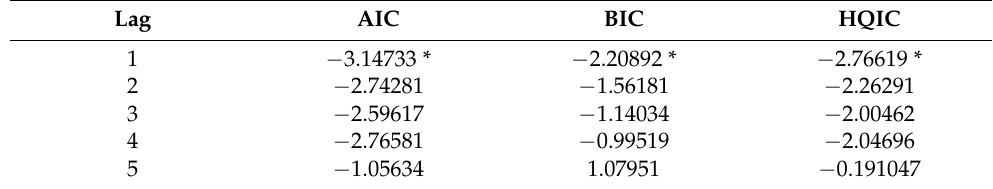
Table 5. Optimal lag order